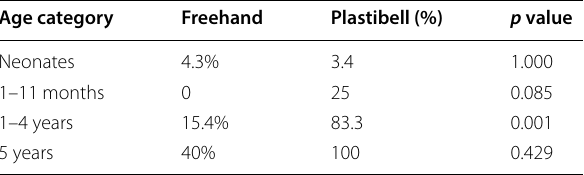
Table 5 Comparison of complications in different age categories between freehand and Plastibell